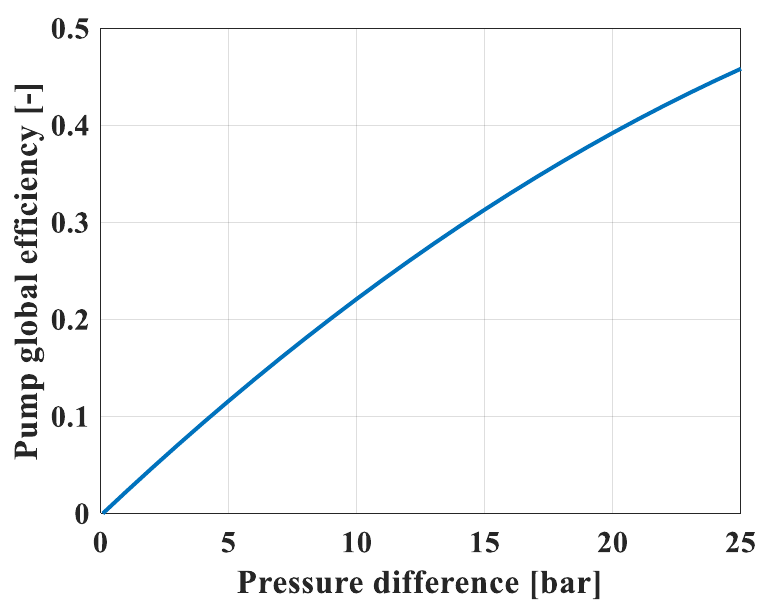
Figure 3. Pump global efficiency as function of pressure difference [18].